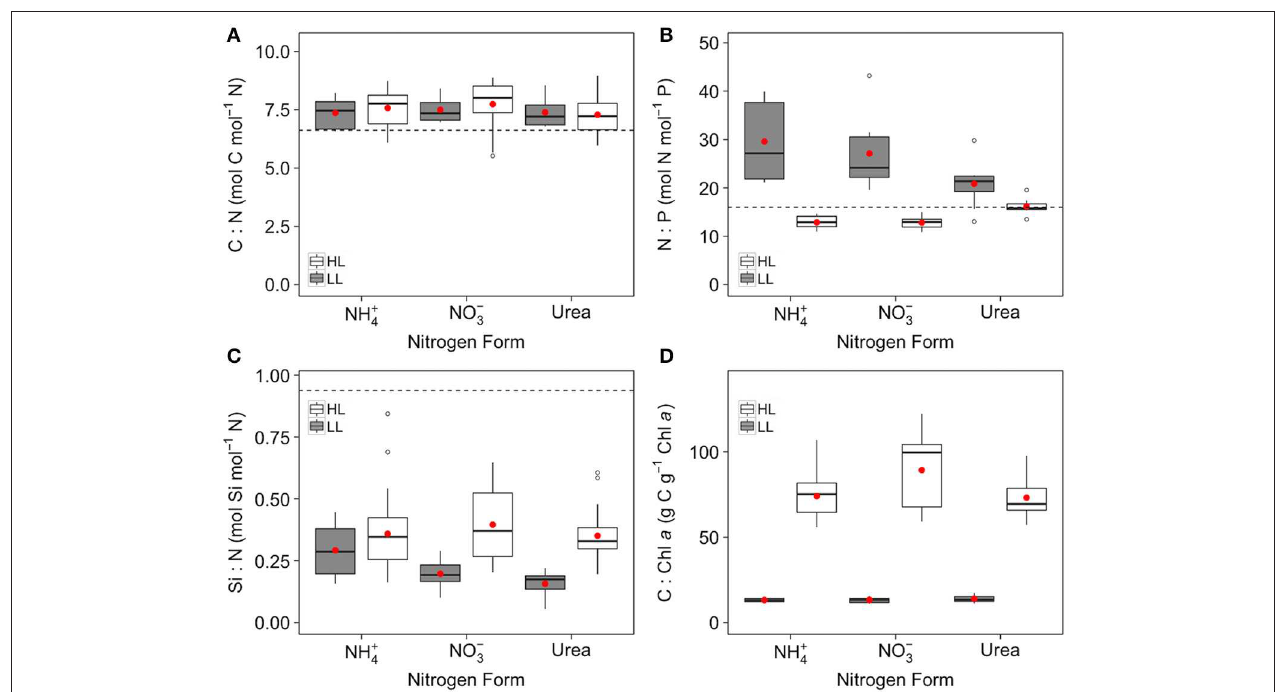
FIGURE 3 | Box plot of C:N ratio (A) , N:P ratio (B) , Si:C ratio (C) , and C:Chl a (D) for C. gelidus acclimated to NH + 4 , NO − 3 or urea under low (5.5 µ mol photons m − 2 s − 1 ; gray) or high (200 µ mol photons m − 2 s − 1 ; white) light at 0 ◦ C ( n > 9). Dashed line indicates the canonical Redfield ratio. Red dots represents